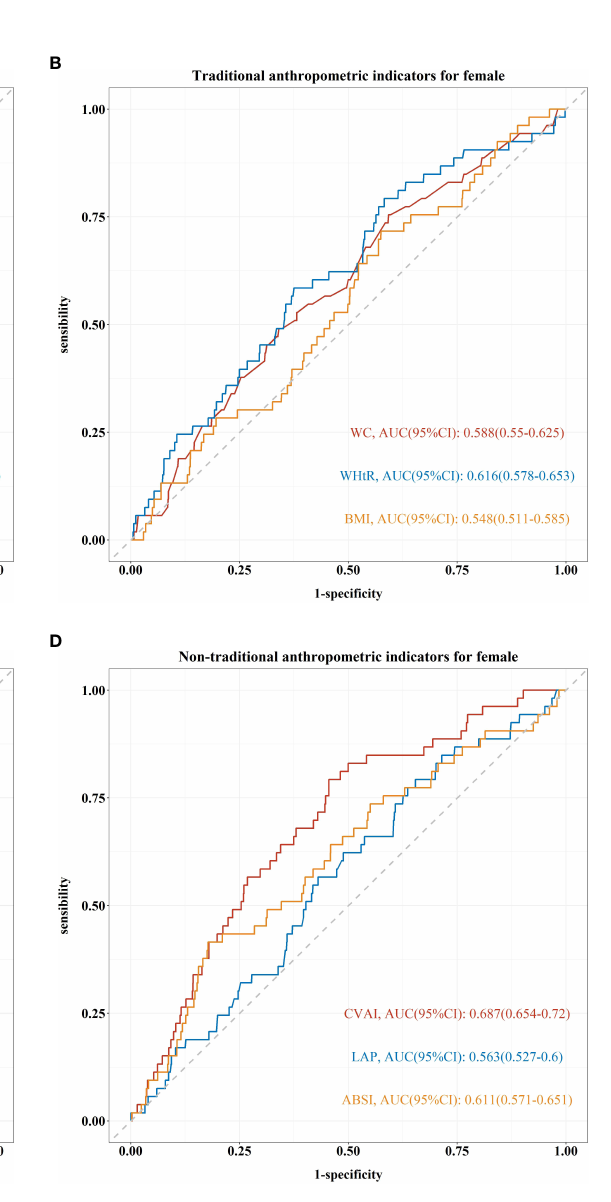
FIGURE 2 Receiver operating characteristic (ROC) curve and area under ROC curve (AUC) of traditional and non-traditional anthropometric indicators for predicting CVD among male and female participants based on the adjusted Cox regression model (Model 3). (A, B) For waist circumference (WC), waist-to-height ratio (WHtR), and body mass index (BMI), respectively. (C, D) For Chinese visceral adiposity index (CVAI), lipid accumulation product (LAP), and body shape index